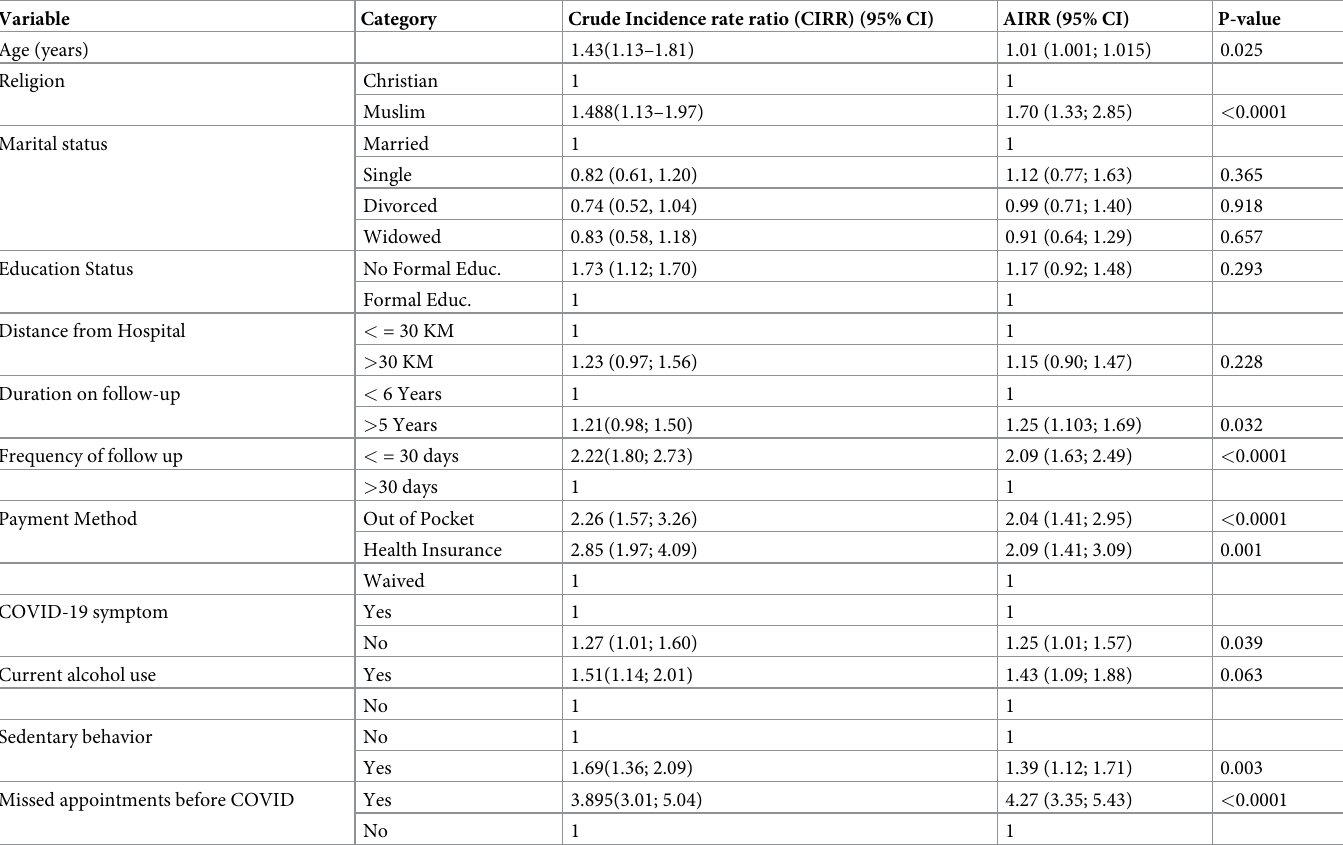
Table 3. Negative binomial regression for missed appointments over demographic, clinical, and behavioral